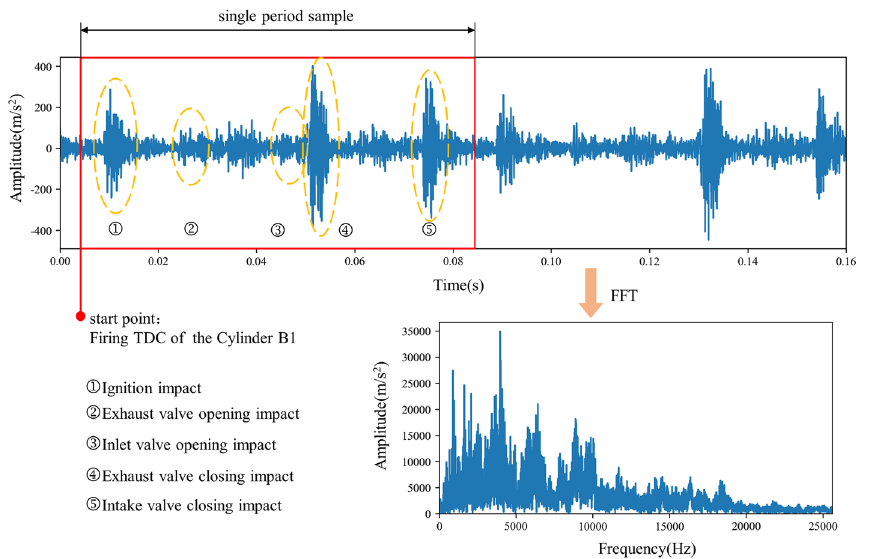
Figure 5. Acquired time and frequency domain